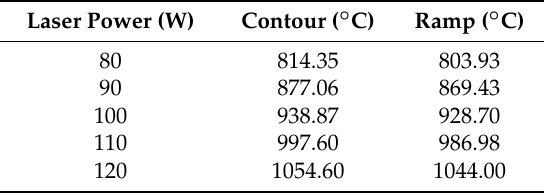
Table 4. Maximum temperature of Inconel 718 each laser